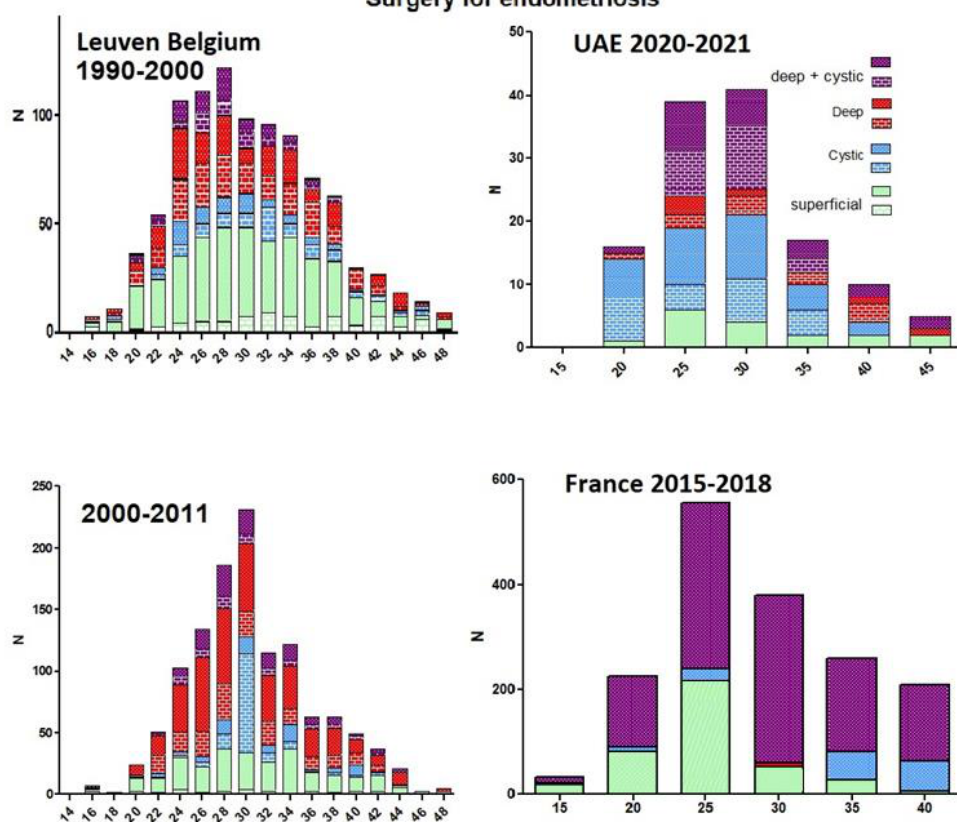
Figure 4. Incidence of laparoscopies and type of endometriosis In Latifa, United Arab Emirates, in France and Belgium. The severity of deep (>2 cm) and cystic (>3 cm) endometriosis is indicated by darker